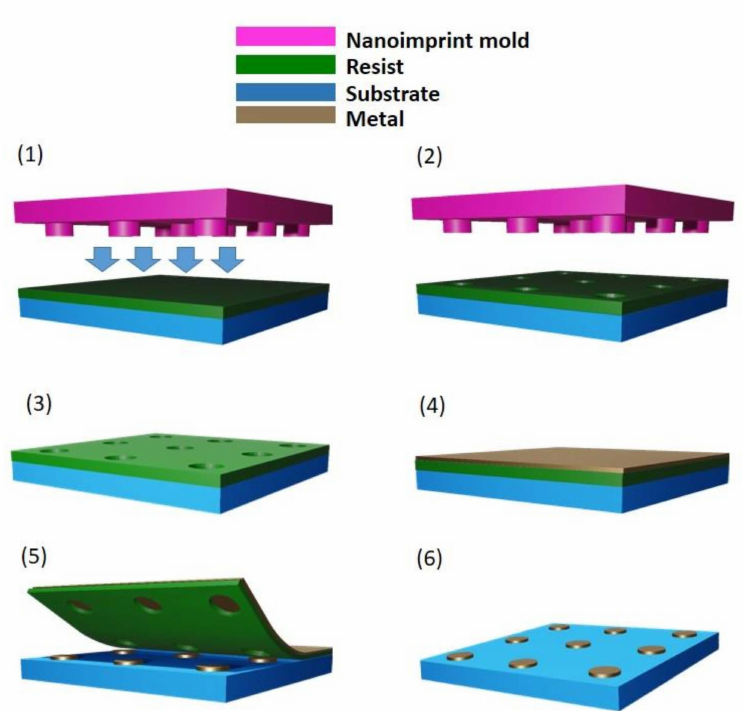
Figure 4. Schematics of substrate prepatterning process by means of nanoimprint lithography for metal-catalyzed nanowire growth: ( 1 ) a mold containing the pattern to be transferred is pressed against a layer of resist spin-coated on the substrate; ( 2 ) the mold is separated from the substrate, ( 3 ) the pattern is transferred to the resist mask; ( 4 ) a thin layer of metal is evaporated; ( 5 ) liftoff; ( 6 ) final metal catalyst